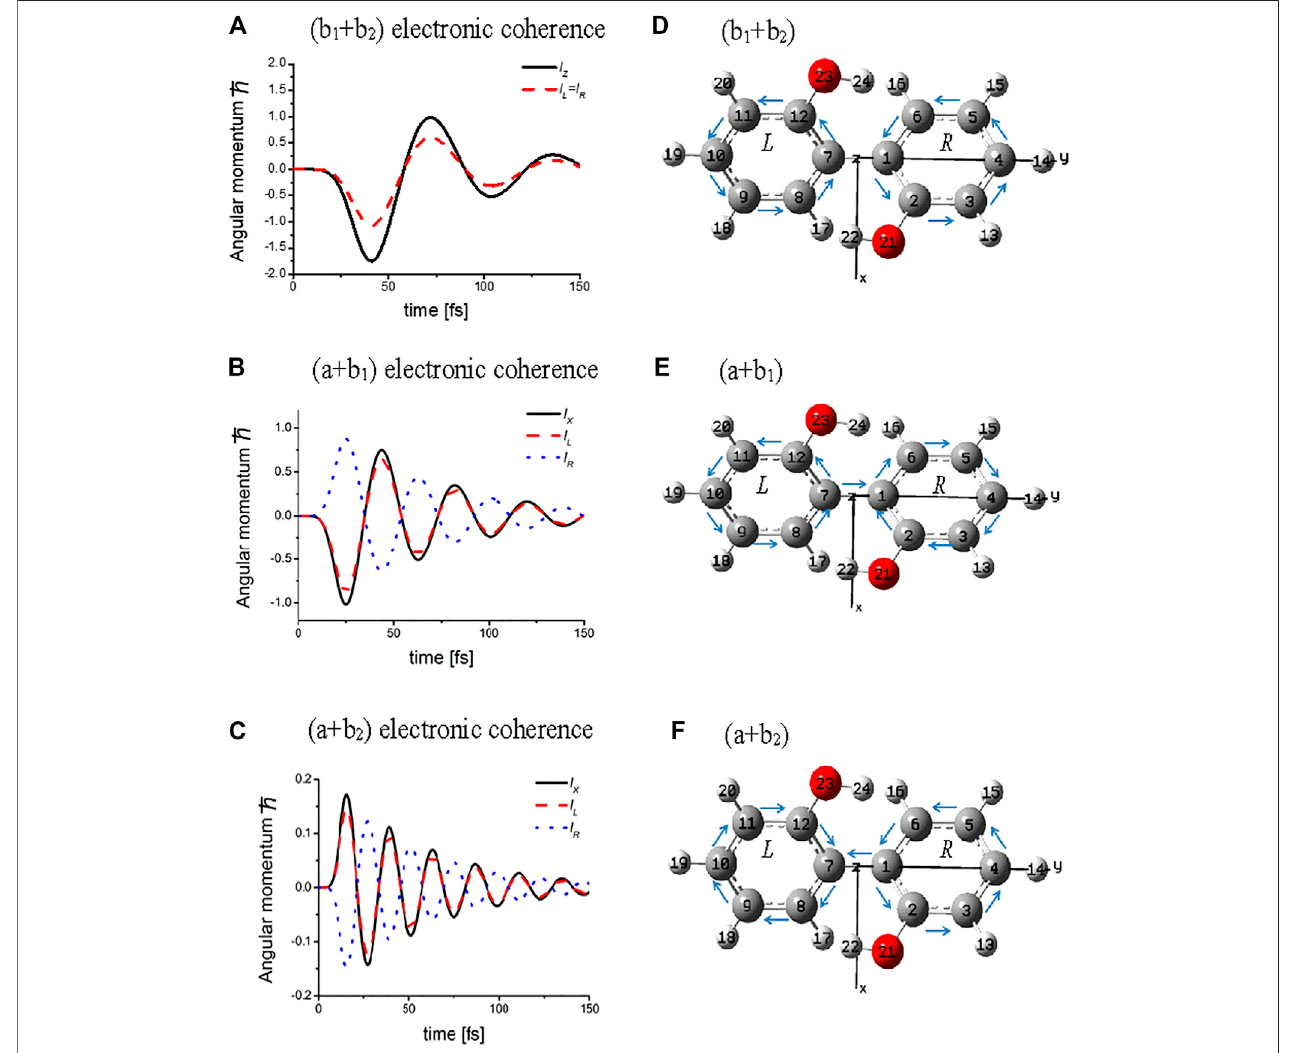
FIGURE3| Temporalbehaviorsofthecoherentangularmomenta, totalvalues l Z ( l X ),andcomponents, l L ( l R )of L ( R )ringforthreetypes oftheelectroniccoherence and the directions of the bond currents at the initial time: upper panel for ( b 1 + b 2 ) electronic coherence excited by laser pulse with amplitude of 0.19 TW/cm 2 ; middle panel for( a + b 1 )electroniccoherence excitedbylaserpulse withamplitudeof0.83 TW/cm 2 ;lowerpanelfor( a + b 2 )electronic coherenceexcitedbythelaserpulsewith amplitude of 3.32 TW/cm 2 . The dephasing constants were set as c b 1 b 2 (cid:2) c ab 1 (cid:2) γ ab 2 (cid:2) 0.01 eV ( ∼ 1/50 fs − 1 ). The arrows above the C – C bonds indicate the initial directionsofthecurrents.Note thatthebridge bondcurrent J 1,7 (cid:2) 0for the( b 1 + b 2 ) electronic coherence,while J 1,7 ≠ 0forthe( a + b 1 ) and ( a + b 2 )electronic coherences. Reprinted with permission from Ref. [39] Copyright (2013) American Institute of Physics.